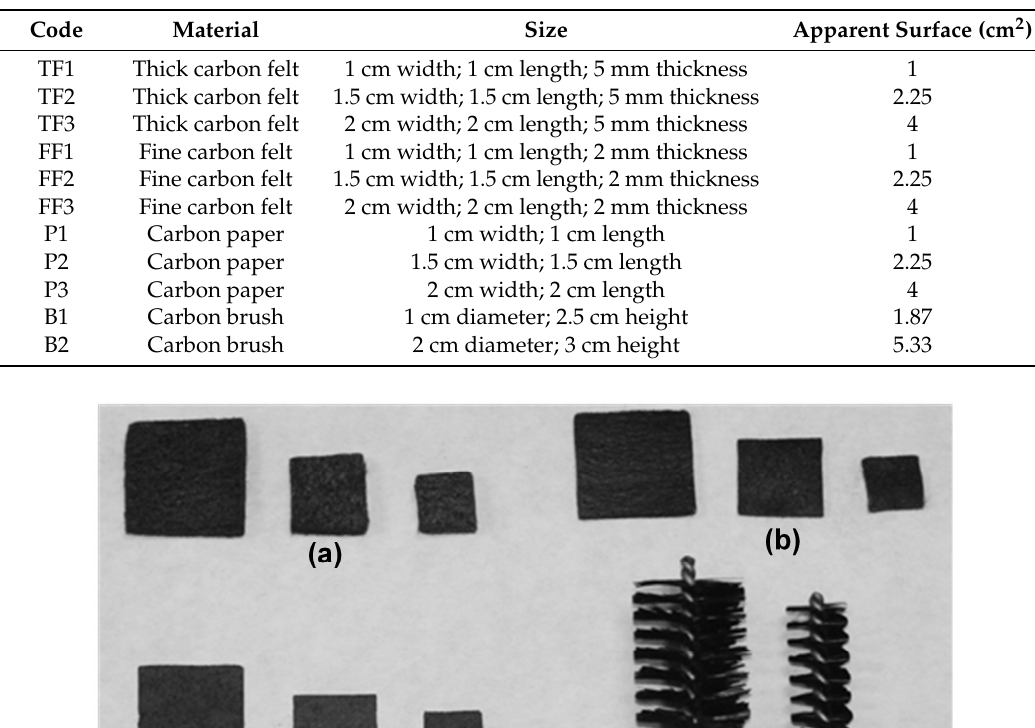
Table 1. Material specification and coding.